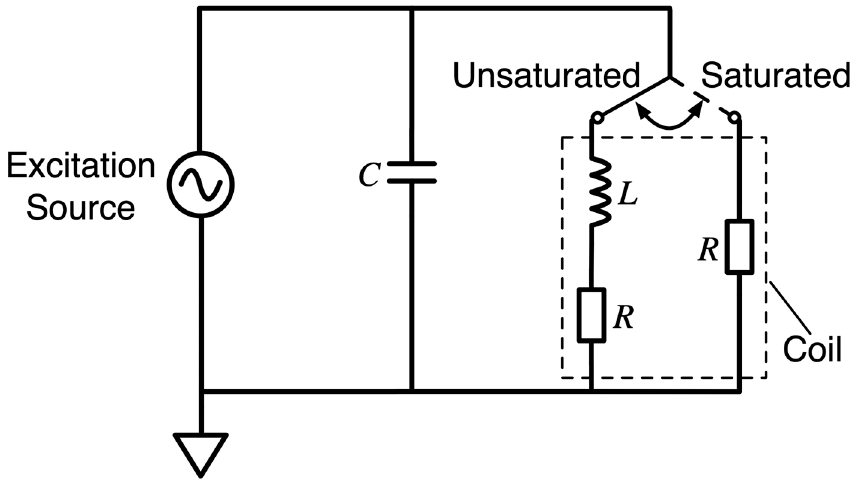
Figure 3. Common fl uxgate excitation circuit structure. Figure 3. Common fluxgate excitation circuit structure.